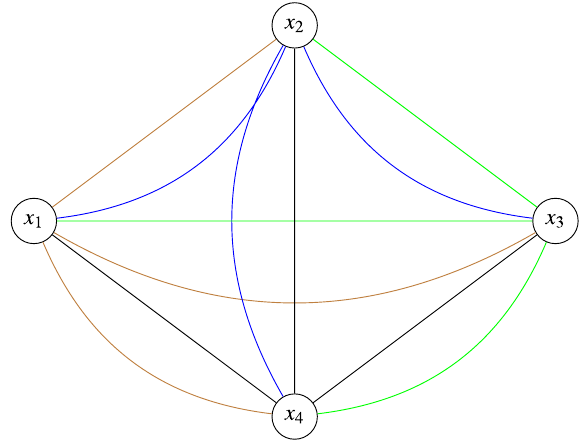
Figure 2. Example plot to show the possible pairs with four locations.